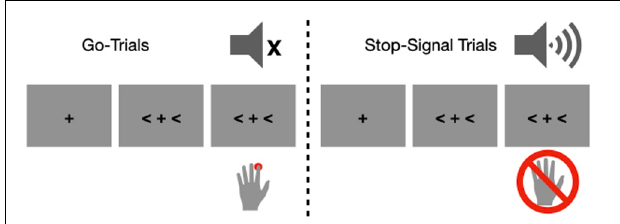
FIGURE 1 | An illustration of the stimulus sequence. In the go trials (left), participants needed to respond to the direction of the arrow signs. In the stop-signal trials (right), participants needed to countermand the action in response to the auditory stop signal.